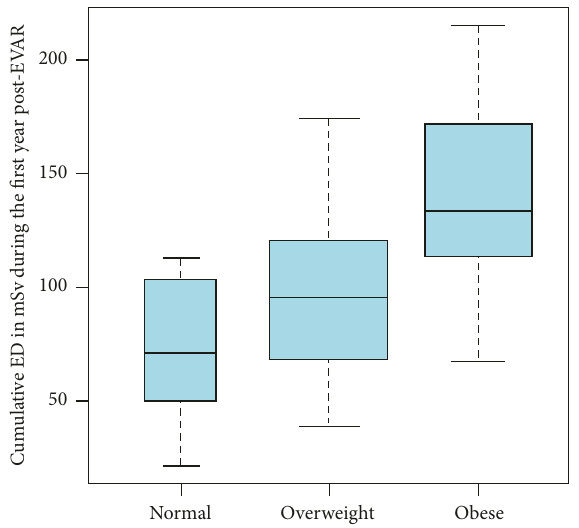
Figure 8: Cumulative ED [in mSv] during the first-year post-EVAR, shownbybodymassindexcategories,withthewidthoftheboxplots adjusted to the number of patients per